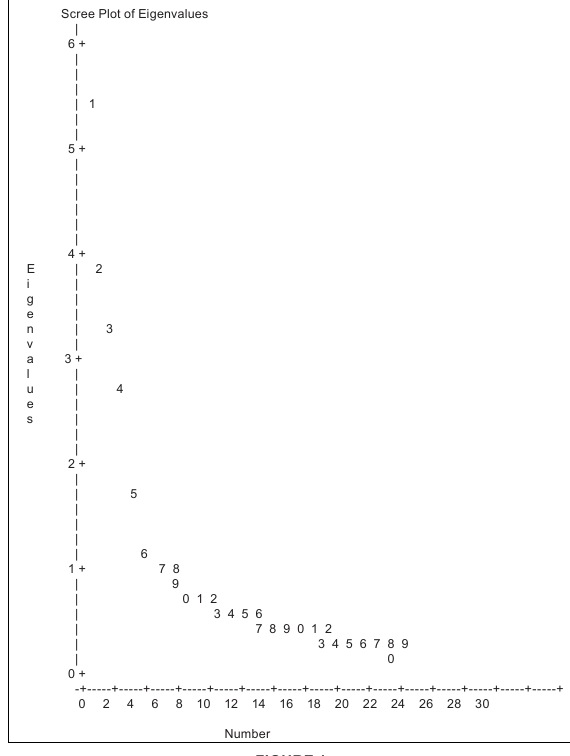
FIGURE 1 Cattell’s scree plot for NEO-PI-R